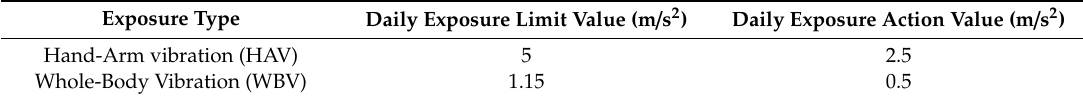
Table 1. Reference values European Directive 2002 / 44 / EC (from the work in